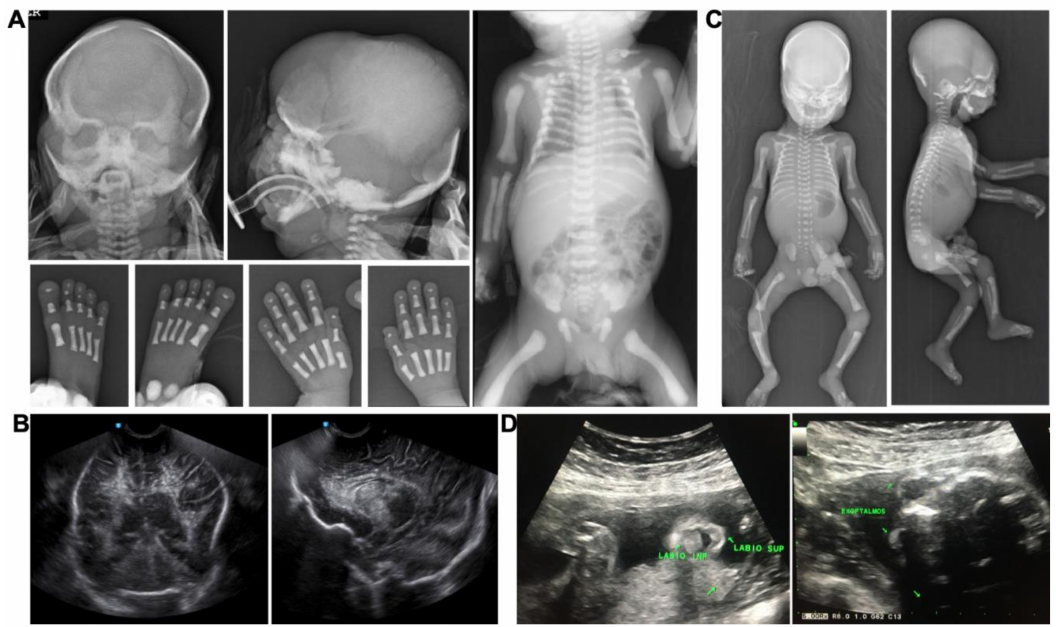
Figure 2. Image findings of cases 1 and 2. ( A ) X-ray of cranium, hands, and feet and babygram of the case 1, showing generalized osteosclerosis, more prominent in cranium base and facial bones, with hypomineralization of the other skull areas; periostic reaction in humerus, distal phalangeal hypoplasia of hands, carpal ossification defects (delayed bone age), and generalized osteosclerosis. ( B ) Transfontanellar ultrasound of case 1, showing brain calcifications, mostly periventricular. ( C ) Babygram of case 2, showing cranium with osteosclerosis, also more prominent in skull base and facial bones, cranial vault hypomineralization, and increased density of all the bones. ( D ) Obstetric structural USG at 21GW of case 2, showing exophthalmos and oral